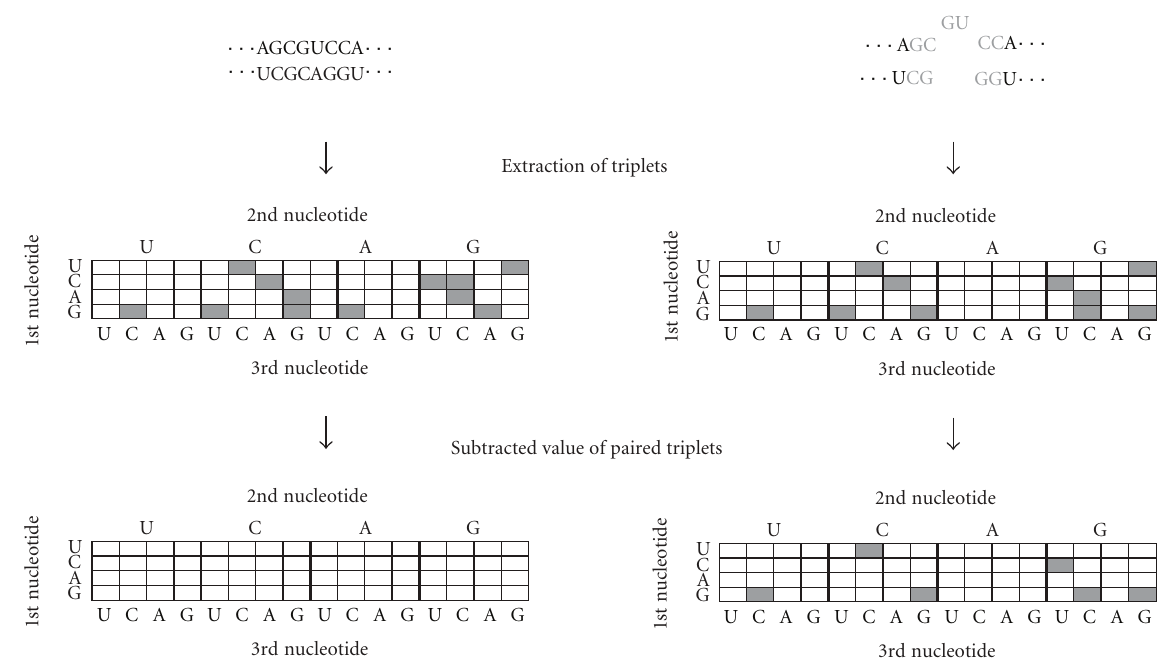
Figure 3: The scheme for the triplet subtraction from a library. Only the triplets from unpaired regions could be determined.